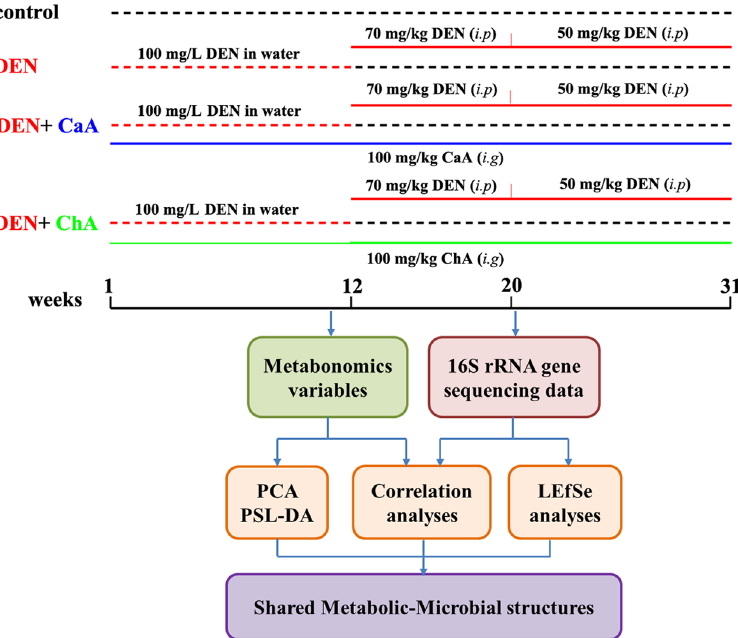
Figure 1. Overview of the experimental design and the analytical